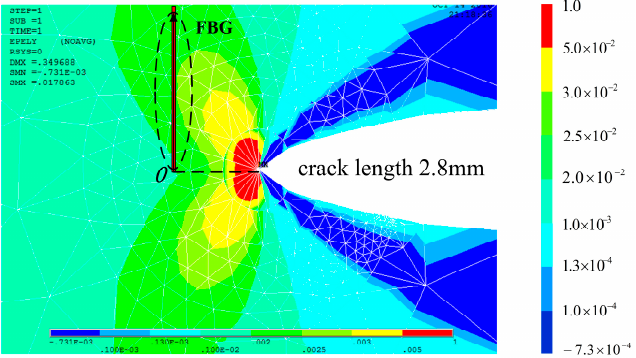
Figure 6. Finite element analysis of a crack with a length of 2.8 mm.